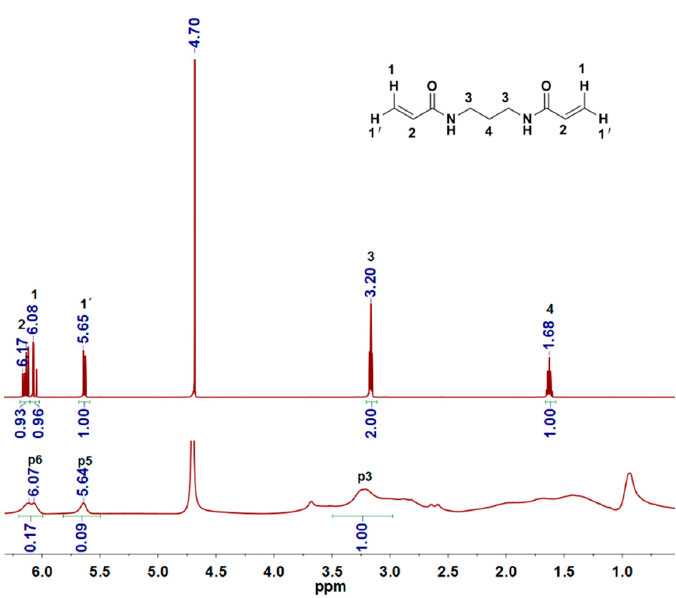
Figure 2. 1 H NMR spectra of hyperbranched polymer and monomer.